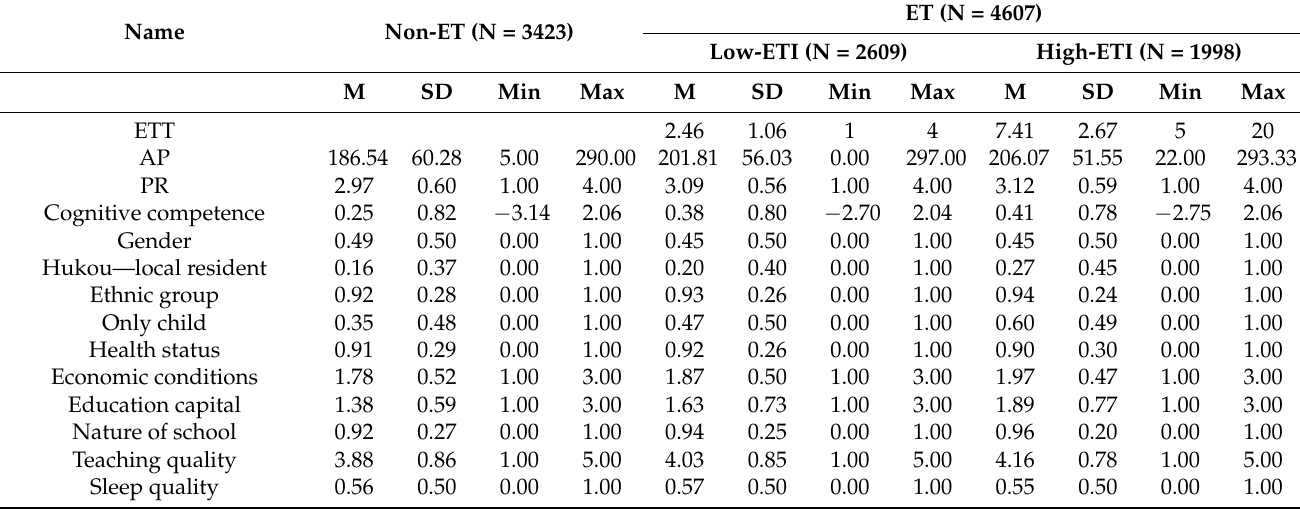
Table 2. Variable descriptive